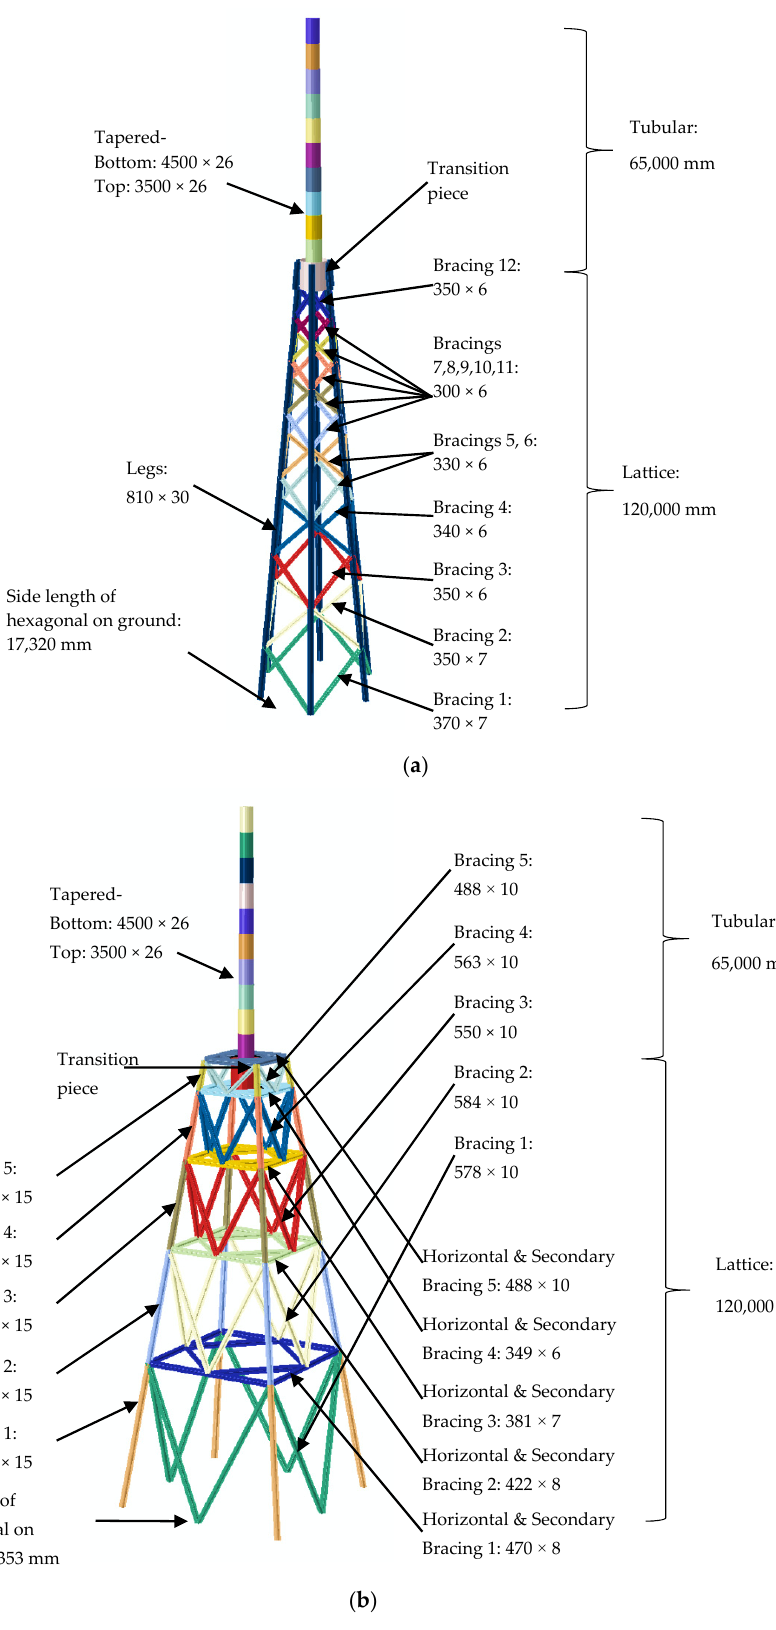
Figure 2. Case studies considered for LCA (dimensions in mm). ( a ) A 6-legged tower, ( b ) A 4-legged tower.